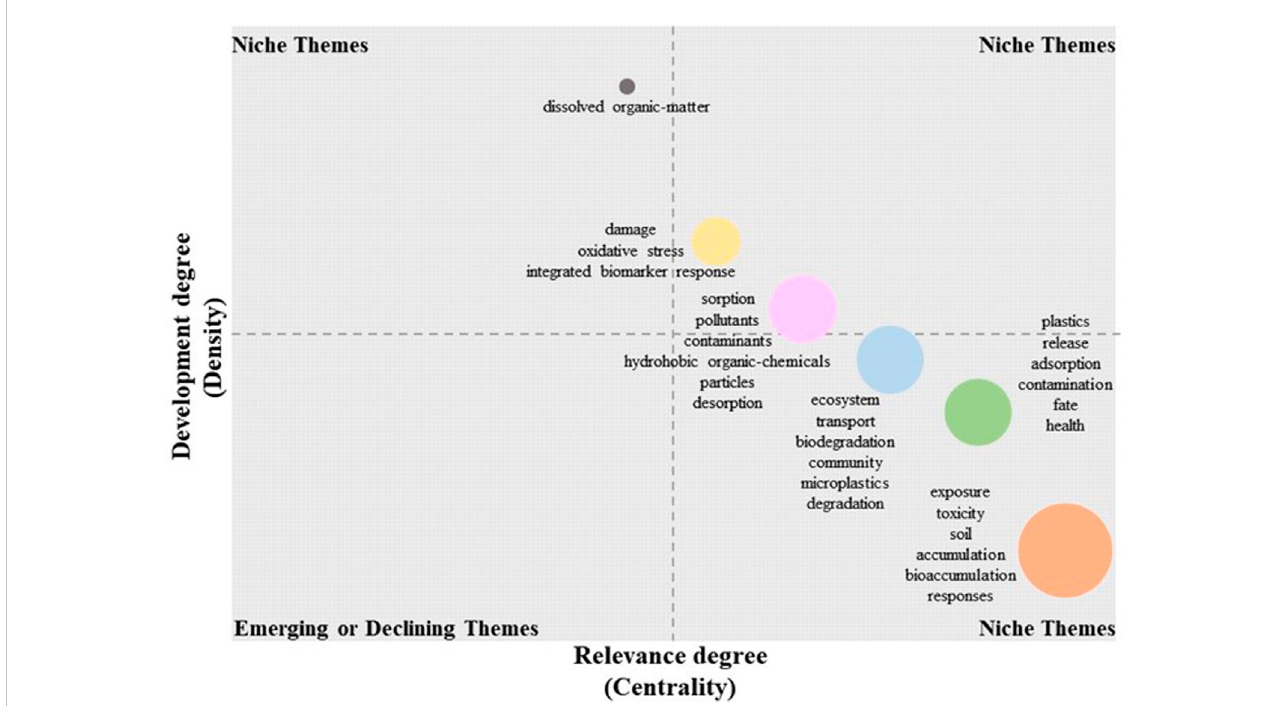
FIGURE 7 Keyword clustering of articles published from 2020 to 2021 focusing on microplastics and earthworms. The minimum frequency of occurrence (per 1,000 documents) for each research direction is more than fi ve. The size of the circles represents the number of articles published in the corresponding direction. The horizontal axis represents relevance (centrality), which measures the importance of a research direction in the overall development of the research fi eld. The vertical axis represents development (density), which measures the current state of development of a research